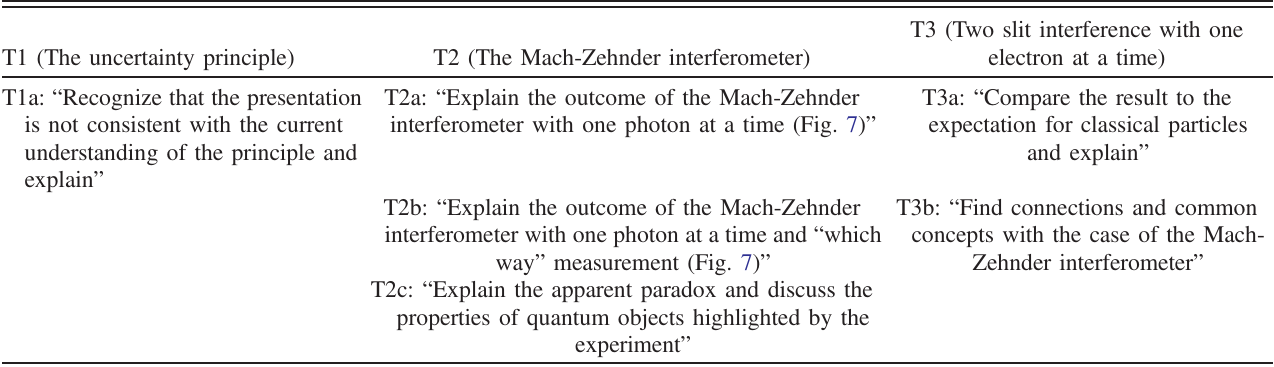
T3 (Two slit interference with one electron at a time)